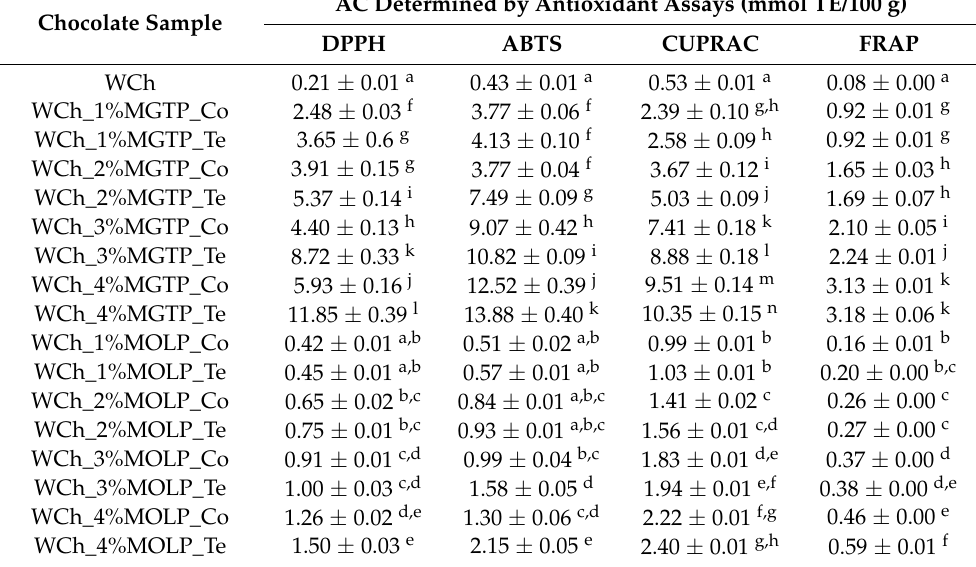
Table 5. Antioxidant capacity of white chocolate with matcha green tea powder and moringa leaf powder added during conching and